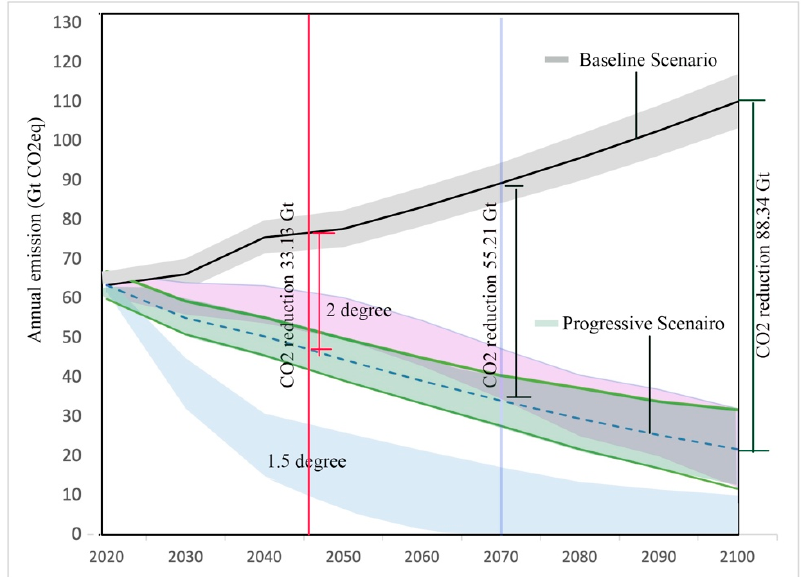
Figure 7. Residential building stock ‐ related emissions in the baseline and progressive scenarios.